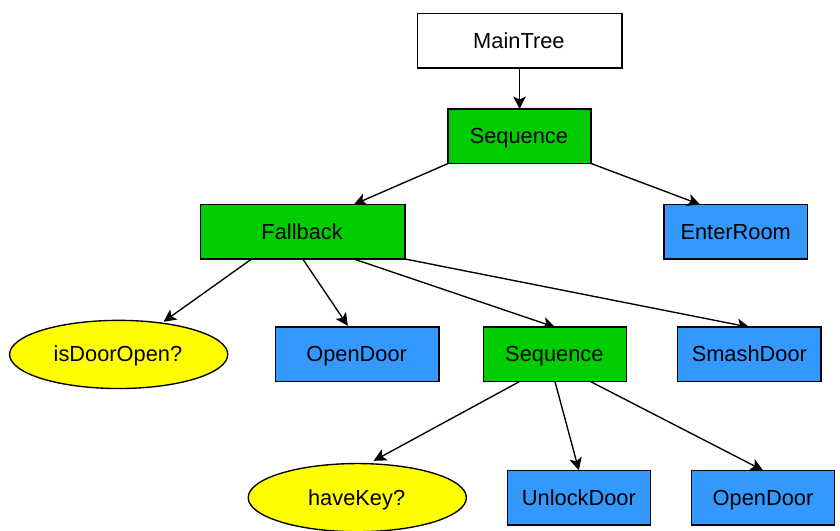
Figure 7. An example of behavior tree. Green boxes are control nodes. Yelow ellipses are conditional nodes and blue boxes are action